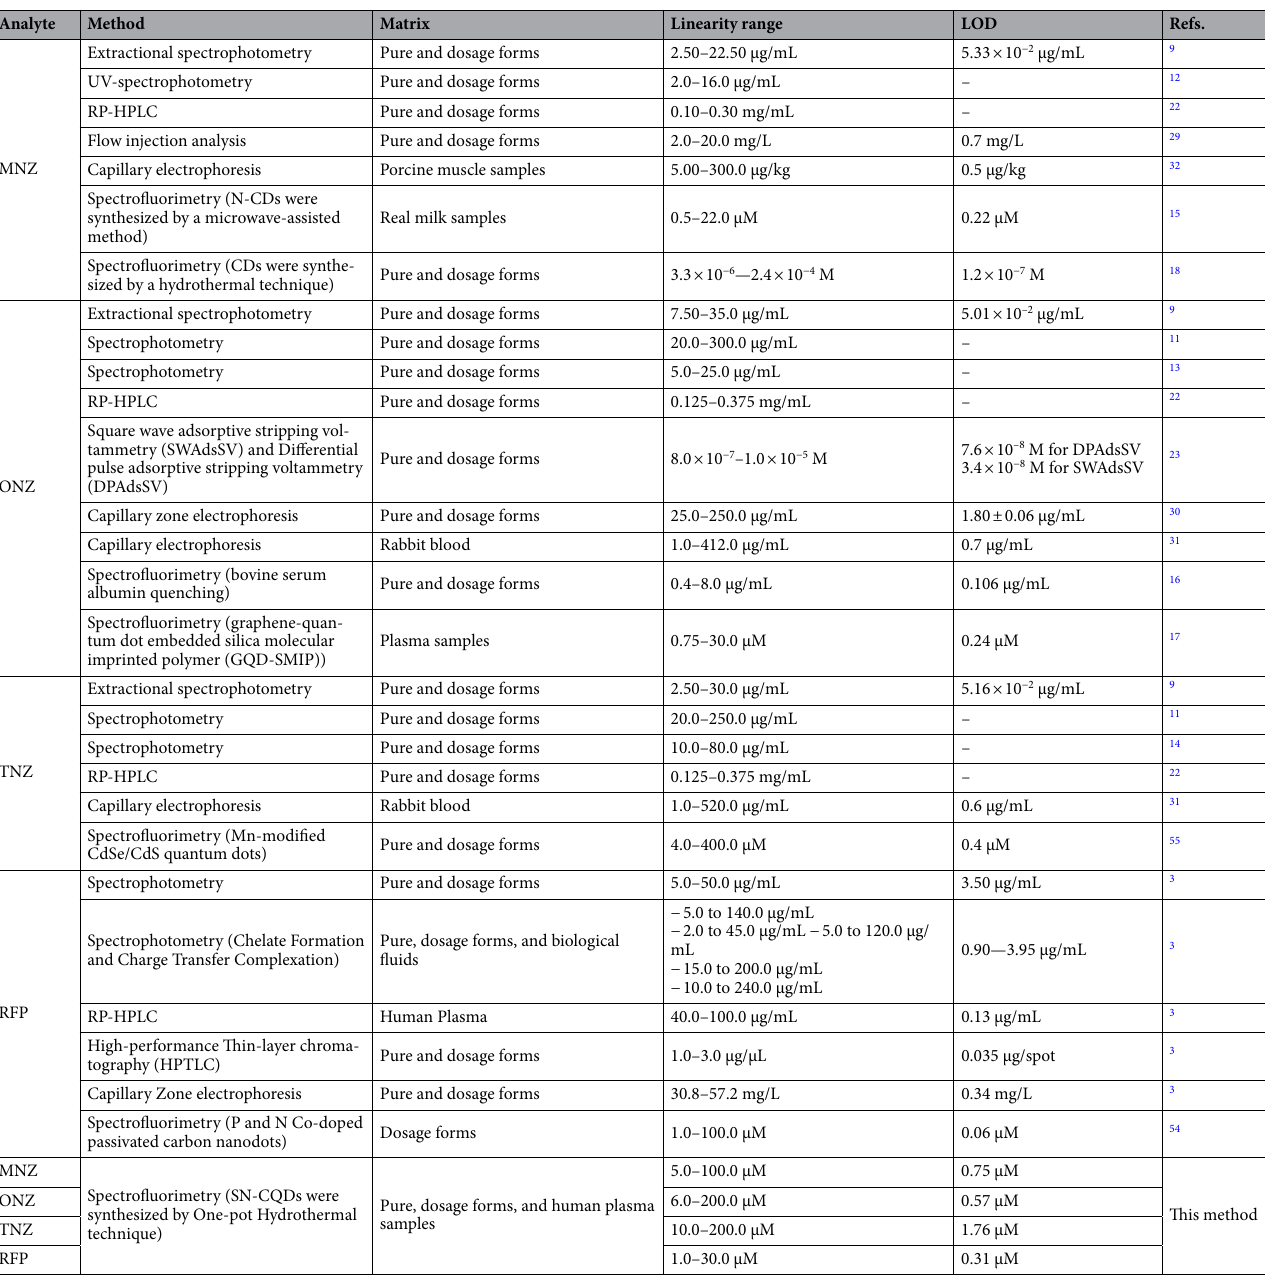
Table 1. Comparison of the proposed method to the previously reported methods for determination of the studied